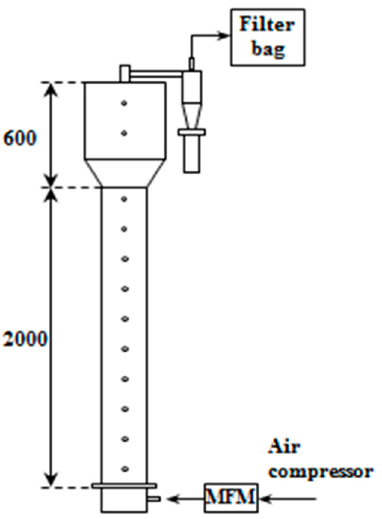
Figure 3. Experimental apparatus for solid holdup measurements.